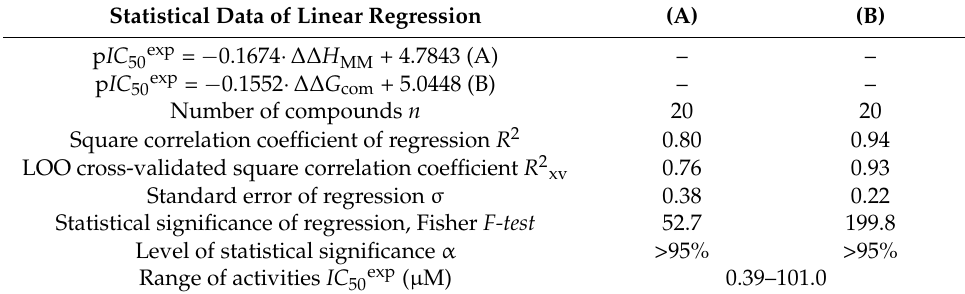
Table 3. Regression analysis of computed binding affinities ΔΔ G com , its enthalpic component ΔΔ H MM , and experimental half-maximal inhibitory concentrations p IC 50exp = − log 10 IC 50exp [12] of pyrrolidine carboxamides (PCAMs) towards InhA of M yco bacterium tuberculosis ( MTb ).